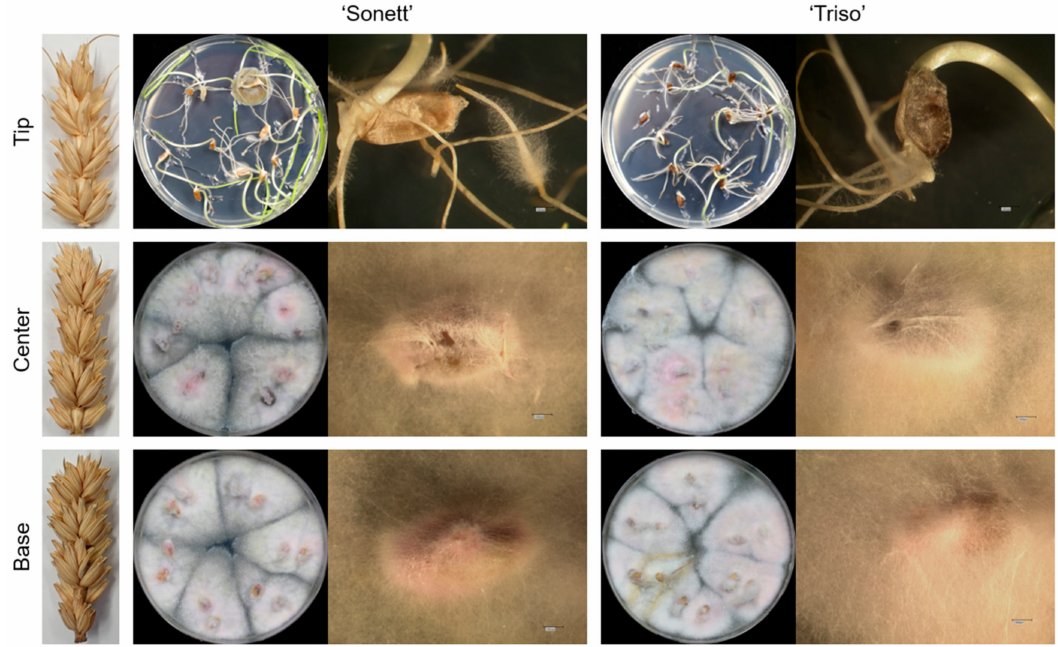
Figure 1. Sampling method and reisolation of Fusarium graminearum from the tips (top row), centers (middle row), and bases (bottom row) of the spikes of spring wheat varieties ‘Sonett’ and ‘Triso’ after inoculation of the central spikelets of the spike (n =